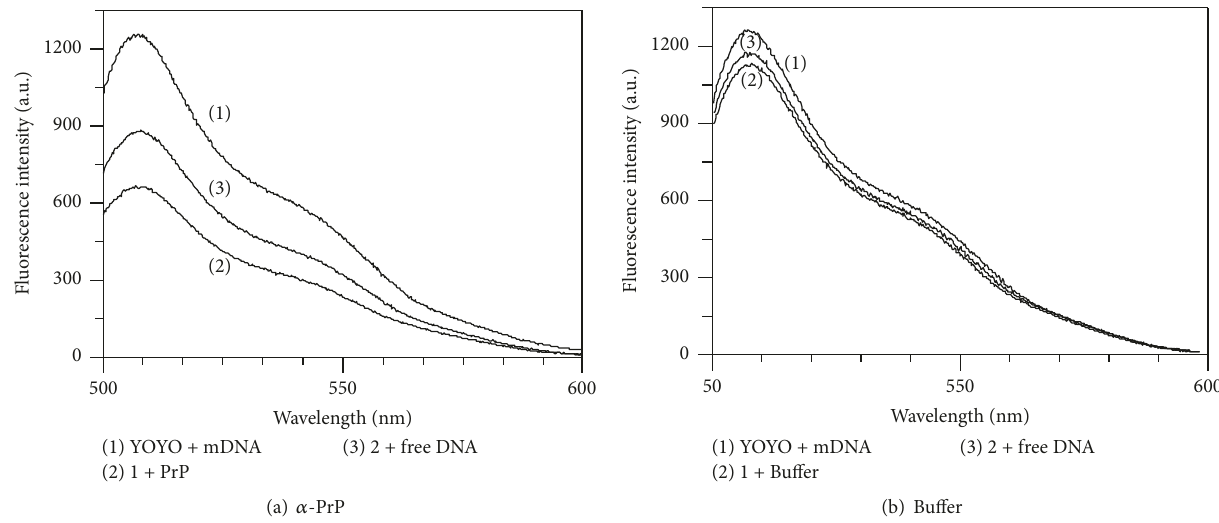
Figure8:QuantificationofthedissociationofYOYOfromDNAduringitscondensationbytheprionprotein.(a)A500 𝜇 lsolutioncontaining YOYO-1 bound to gcDNA (DNA-phosphate 1 𝜇 M; dye to DNA 1: 50) yields the spectrum (1). The addition of 38 𝜇 l of stock 𝛼 -PrP (40 𝜇 M) to the solution (final protein concentration 3 𝜇 M) after 1hr incubation yields the spectrum (2). Following this, 4 𝜇 l gcDNA having 150 𝜇 M phosphate concentration was further added to the solution resulting in 1 𝜇 M free DNA concentration which yielded the spectrum (3). (b) Control experiment. Spectrum (1) is YOYO bound gcDNA as in (a); (2) and (3), respectively, are the spectra after the addition of 38 𝜇 l buffer (instead of protein as in (a)) followed by the addition of gcDNA having 1 𝜇 M final DNA